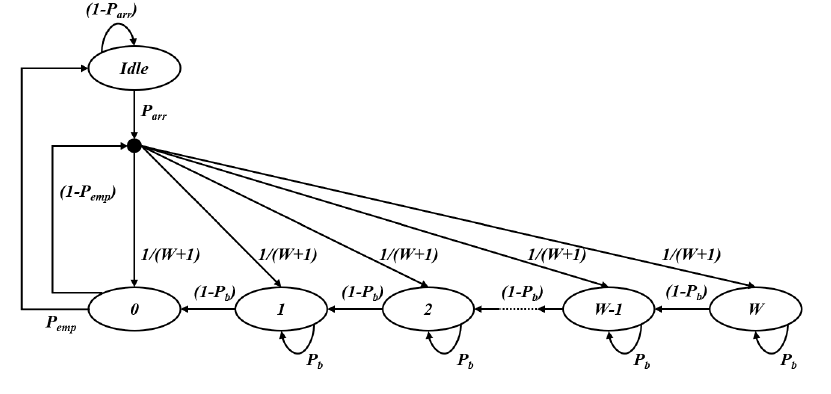
Figure 5. Markov chain model for the backoff